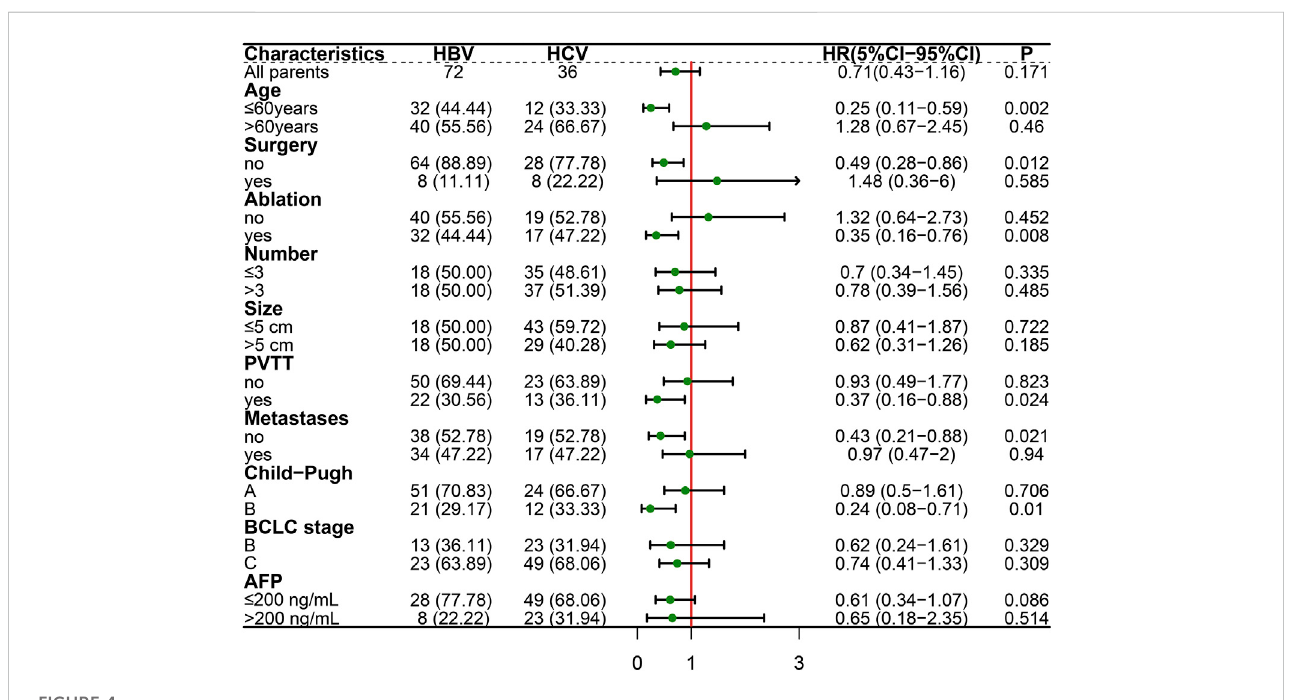
FIGURE 4 Subgroup analysis of progression-free survival in lenvatinib-treated